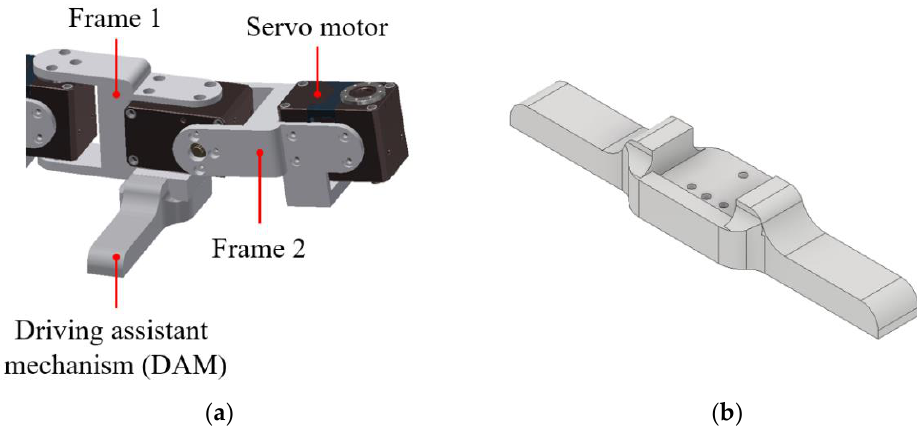
Figure 2. Modeling of a snake robot with a DAM. ( a ) Snake robot with a DAM. ( b ) Design of the DAM.